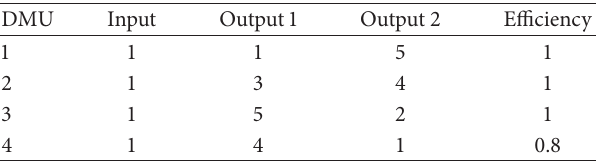
Table 1: The data of four